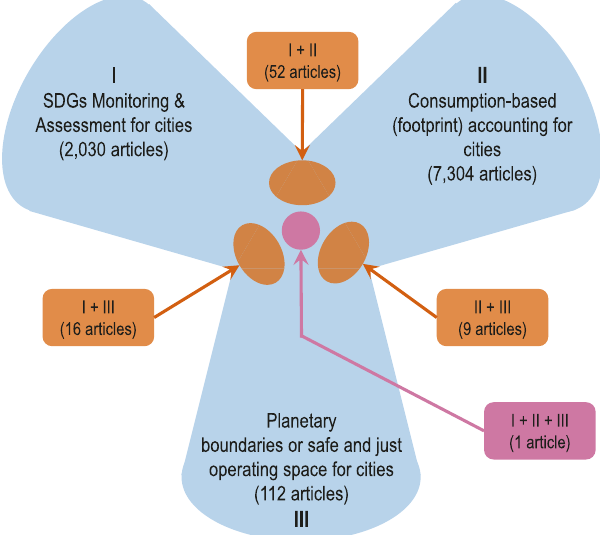
Fig. 1 Conceptual map of the literature landscape related to this